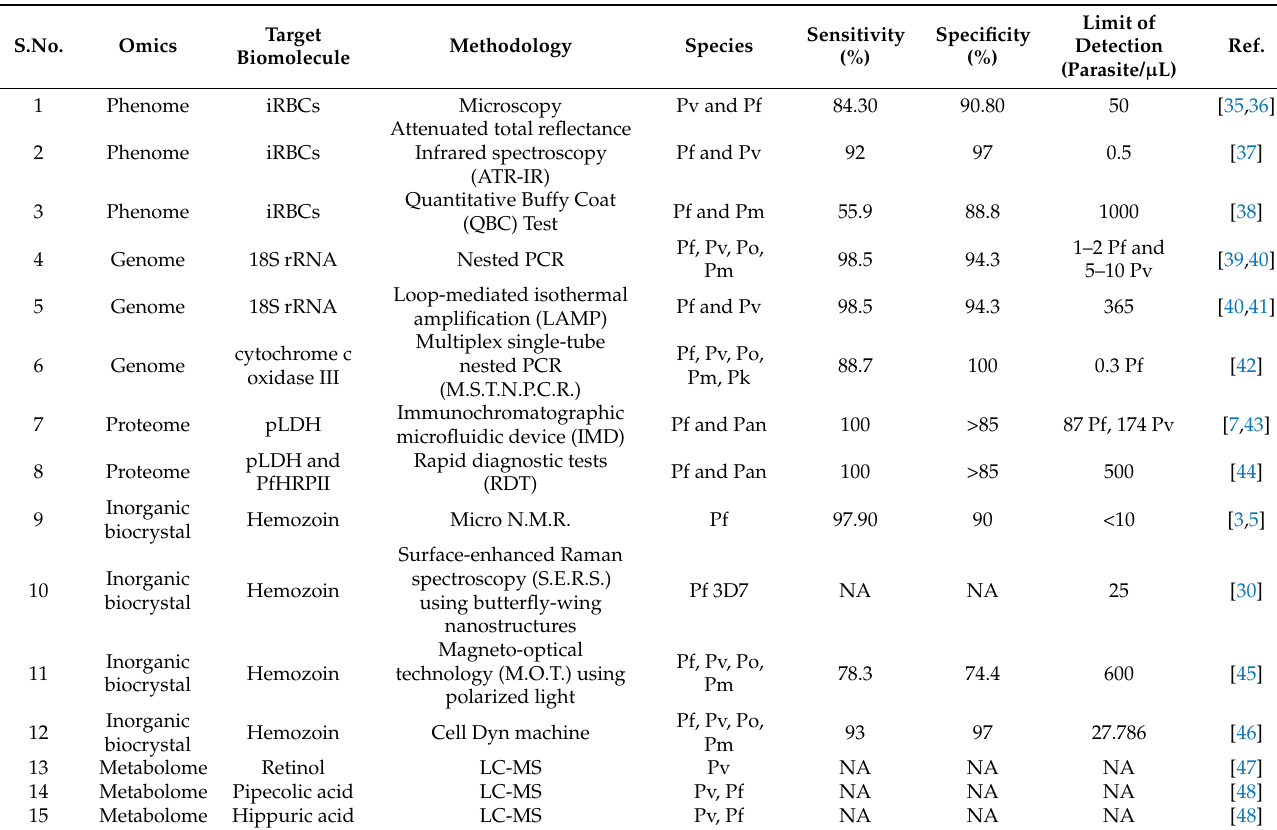
Table 2. List of tools for malaria